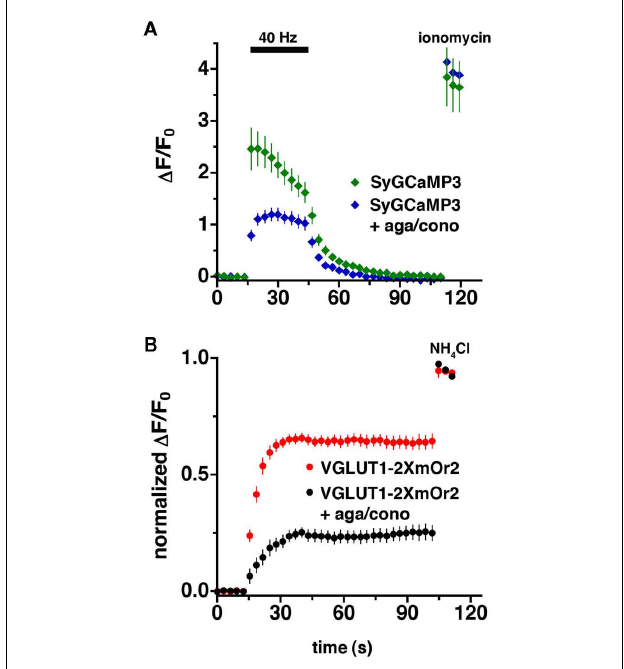
FIGURE 3 | Imaging ofVGLUT1-2xmOr2 and SyCaMP3 during exocytosis. The average time course of changes in fluorescence intensity at boutons expressing both (A) SyGCaMP3 and (B) VGLUT1-2XmOr2 in the absence (green, red) and presence (blue, black) of agatoxin and conotoxin during and after stimulation at 40Hz for 30s.The increase in fluorescence produced by 40Hz stimulation in the presence of bafilomycin is shown here corrected for the rate of fluorescence increase produced by the drug in the absence of stimulation (Sankaranarayanan and Ryan, 2000;Voglmaier et al., 2006). In the presence of the P/Q- and N-type Ca 2 + channel blockers, ω -agatoxinTK (300nM), and ω -conotoxin GVIA (1 μ M), the peak fluorescence of bothVGLUT1-2XmOr2 (black) and SyGCaMP3 (blue) is decreased. Data are means ± SEM of the change in fluorescence ( Δ F ) normalized to initial fluorescence over at least 30 boutons per coverslip from 7 to 12 coverslips and at least three independent cultures.